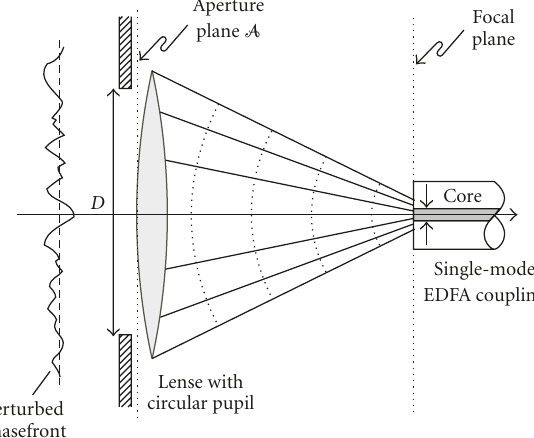
Figure 4: Coupling geometry: A thin lens focuses the incident field E , which is assumed to have constant amplitude but a statistically disturbed phase, onto the bare end of a single-mode